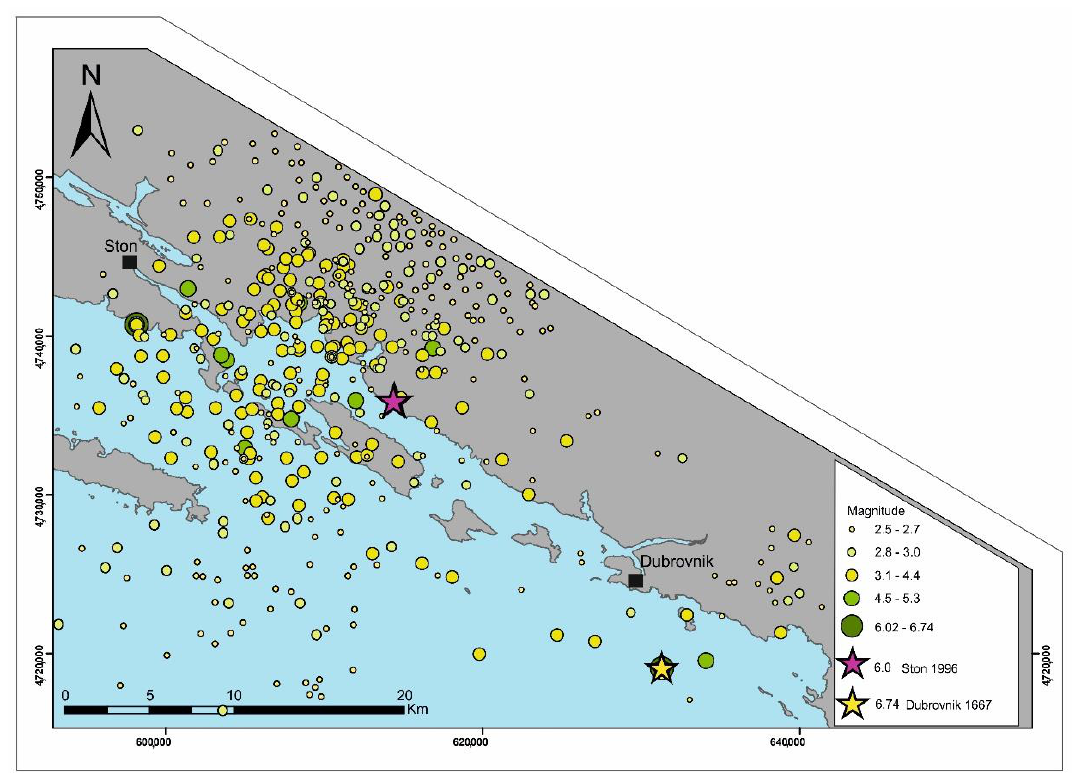
Figure 2. The spatial distribution of earthquakes from years 1471–2014, with a combination of numerous aftershocks within the 50 km radius around Ston which lasted for a year (modified from [50,51]). Data from the past also indicate significant seismic activity. A good example is the great Dubrovnik earthquake of 1667, which had an epicenter intensity of X ◦ MSC [25,49]. The structural characteristics of this area correspond to the basic tectonic elements of the External Dinarides, namely the domination of folded structural elements, the distinct linearity of the structures, the direction of the Dinaric strike, and the dense network of faults. According to [25,52,53], the most important fault assemblies are the Ploˇce–Dubrovnik and Pelješac–Dubrovnik faults. The Ploˇce–Dubrovnik zone has a variable width up to 1.5 km wide. The fault inclination is between 45 ◦ and 82 ◦ . The Pelješac–Dubrovnik structural assembly is represented by a zone of parallel faults which are 1.5–4.5 km wide. The Koloˇcep bay basin lies between two major seismogenic fault zones: the southern Dubrovnik fault zone and the Mt. Mosor–Mt. Biokovo